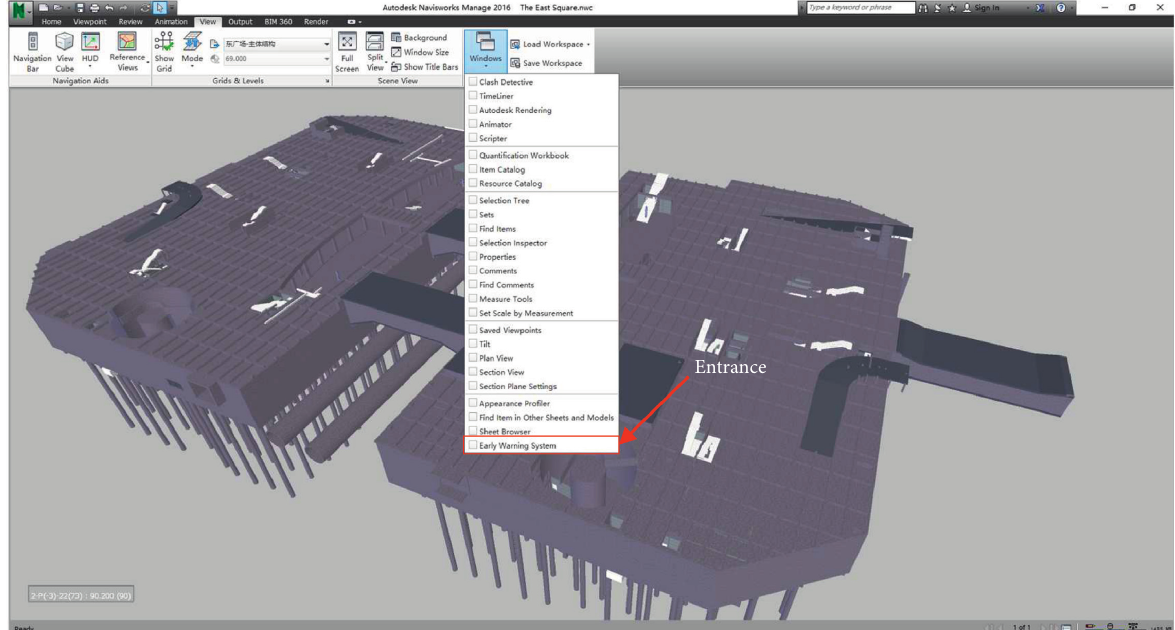
Figure 12: Menu of the safety risk early warning